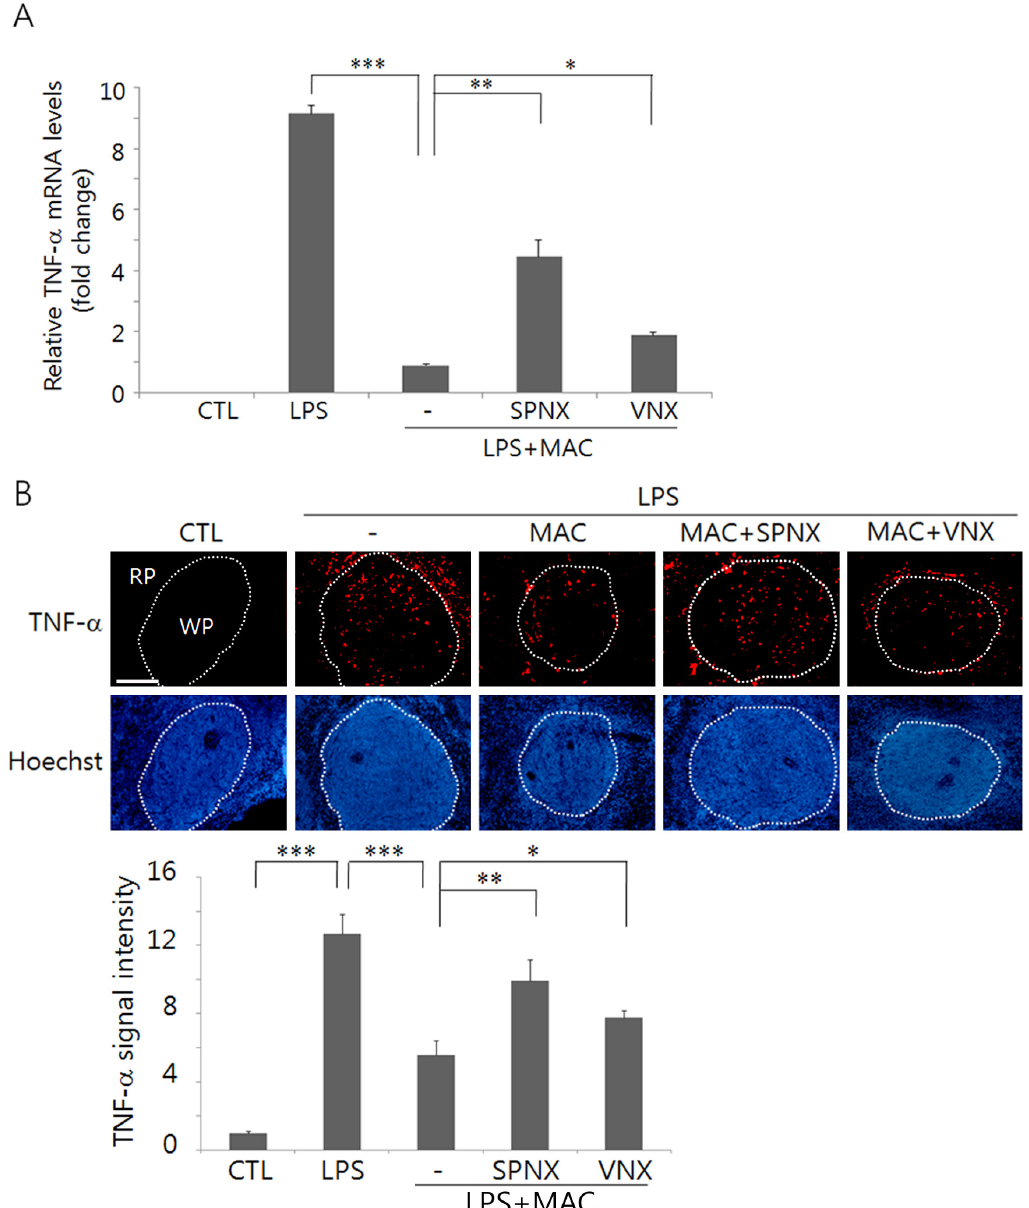
Fig 2. Regulation of TNF- α production by using MAC and a splenic neurectomy (SPNX) and a vagotomy (VNX). (A) A real-time PCR analysis for TNF- α mRNA expression in the spleen. Graph shows the fold changes of TNF- α mRNA levels in each group relative to internal loading control GAPDH mRNA. (B) Changes in the TNF- α protein signals due to MAC, SPNX, and VNX. The upper pictures are the representative images, and the lower graph shows quantitation of the protein signals in the field. (WP: white pulp, RP: red pulp). Spleen tissues were prepared from animals that had been sacrificed 90 min after AS and were used for real-time PCR and immunofluorescence analyses. * p < 0.05, ** p < 0.01, *** p < 0.001 (one-way ANOVA in A and B; n = 4 independent experiments). CTL shows the non-treated controls. The scale bar in (B) is 100 μ